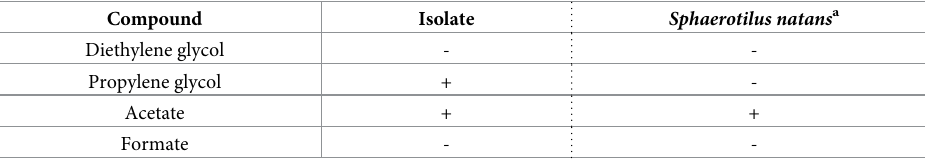
Table 2. Deicer-related compound utilization. Compound Isolate Sphaerotilus natans a Diethylene glycol - - Propylene glycol + - Acetate + + Formate -